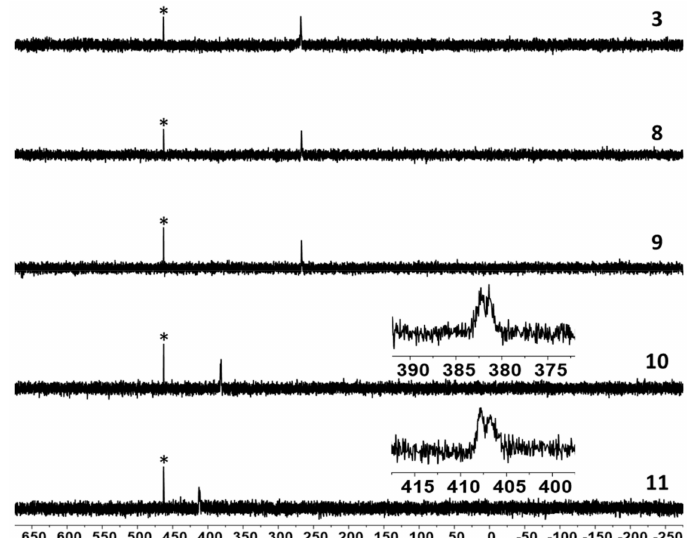
Figure 6. 77 Se-NMR of polymers 3 , 8 , 9 , 10 , and 11 . The signal from the standard (PhSeSePH) is shown with the help of an asterisk.